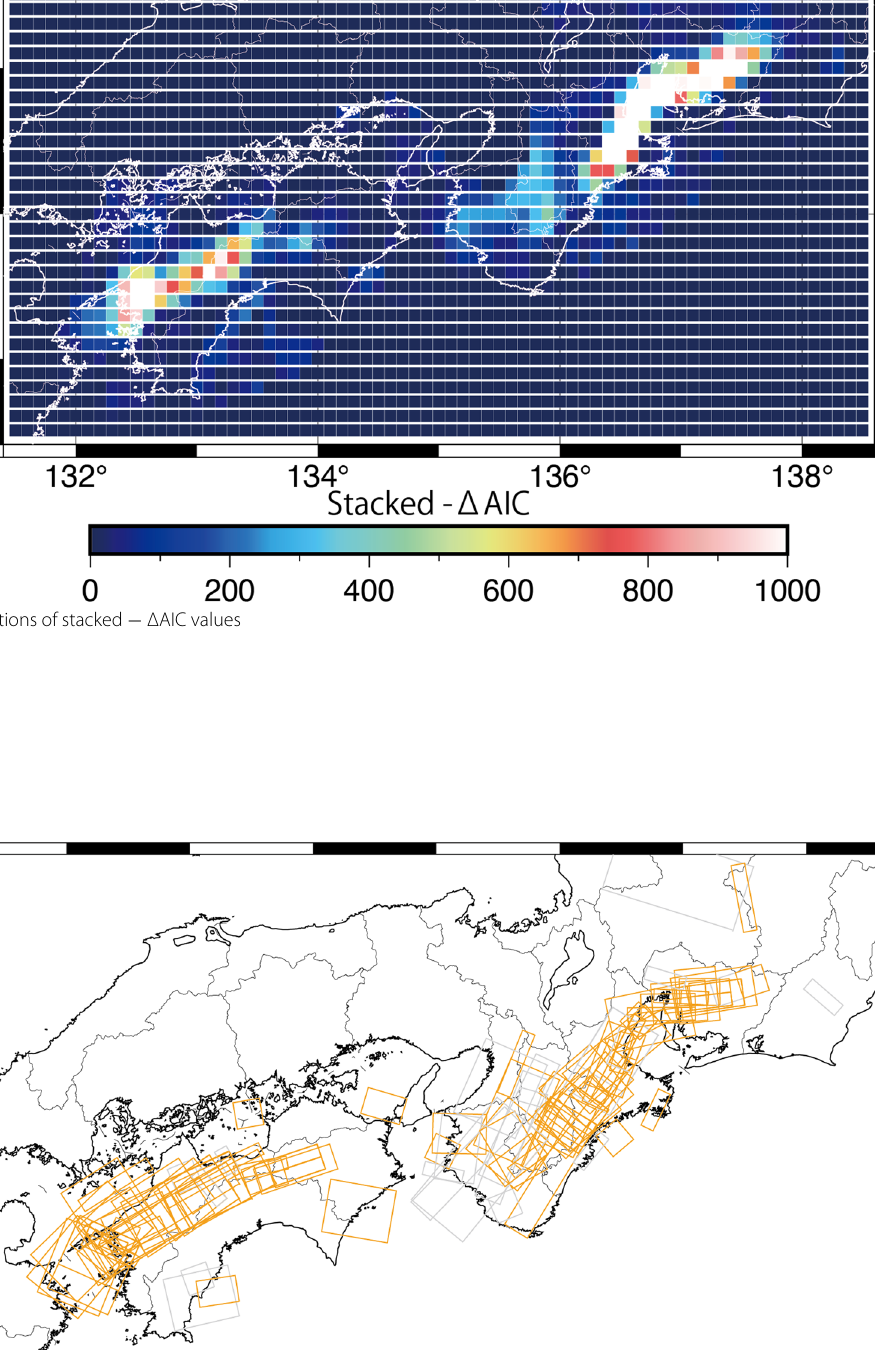
Fig. 6 Spatial distributions of detected events in this study. Orange squares are detected possible SSEs. Gray squares are events detected in the period of heavy rainfalls (> 50